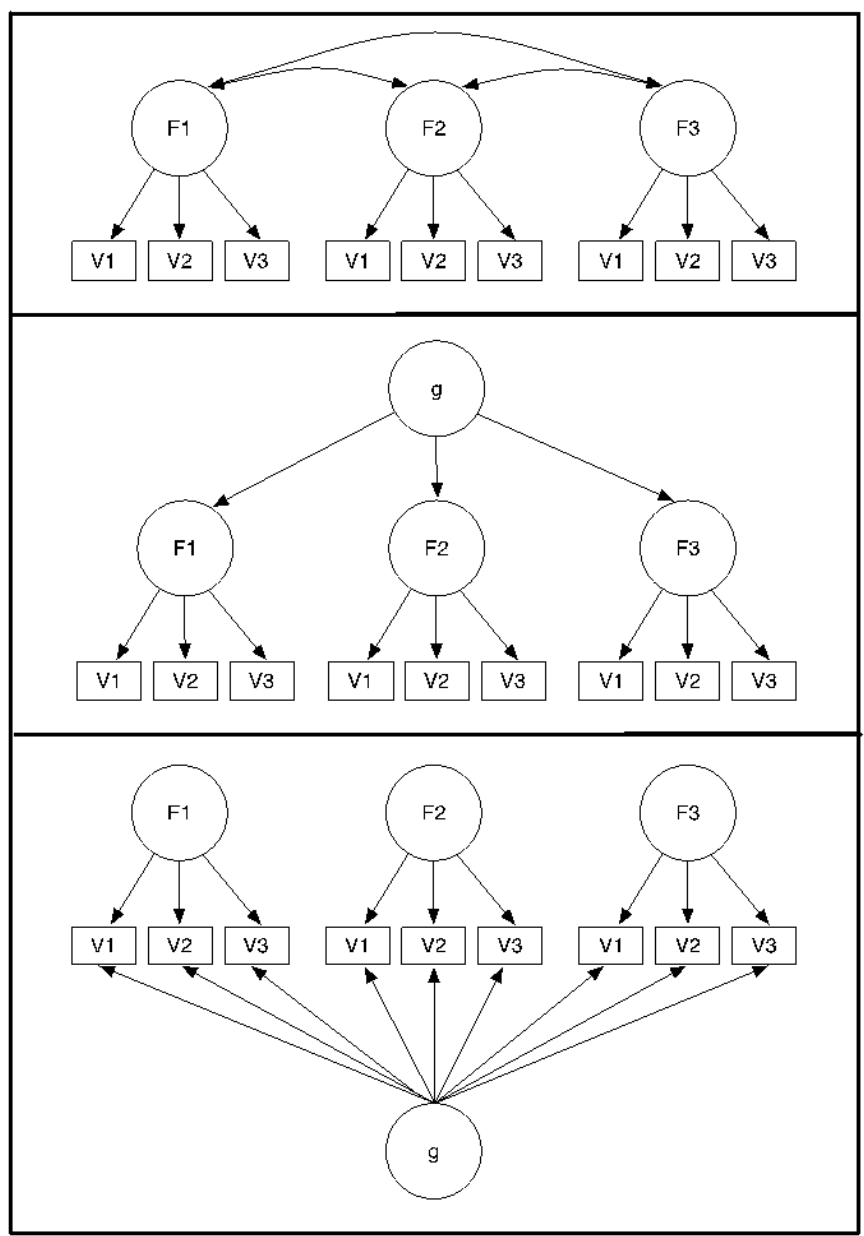
Figure 1. Multiple correlated factor (top panel), higher-order (middle panel), and bi-factor (bottom panel)